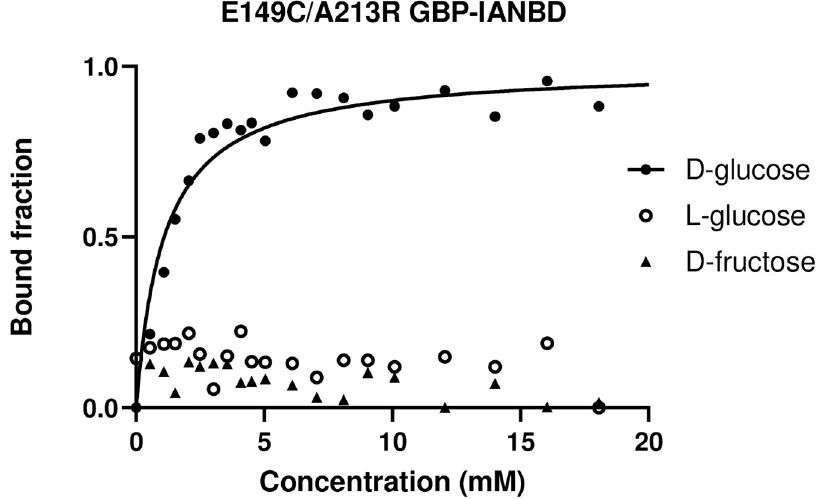
Fig 4. Fluorescence associated with bound fraction of E149C/A213R GBP-IANBD with increased concentration of D-glucose (circles) compared to L-Glucose (squares) and D-fructose (triangles). The curve for D-glucose was fitted using the one site-specific binding with Hill slope formulae in GraphPad prism. Curves could not be fitted for L- glucose or D-fructose.